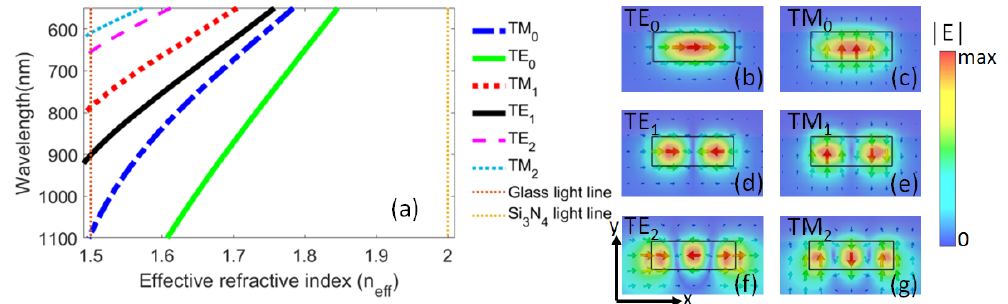
Figure 2. Modes guided by the waveguide. ( a ) Dispersion curves of the dielectric Si 3 N 4 waveguide in the spectral range from 500 nm to 1100 nm. The maps show the | E | field distribution and electric field lines, computed at λ = 550 nm, of the ( b ) TE 0 , ( c ) TM 0 , ( d ) TE 1 , ( e ) TM 1 , ( f ) TE 2 , and ( g ) TM 2 modes launched at the input of the